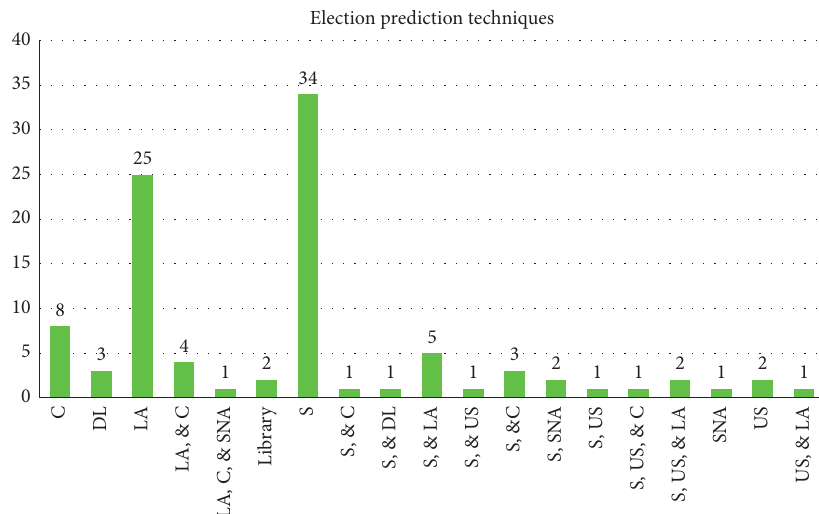
Figure 7: Election prediction techniques with the number of studies using